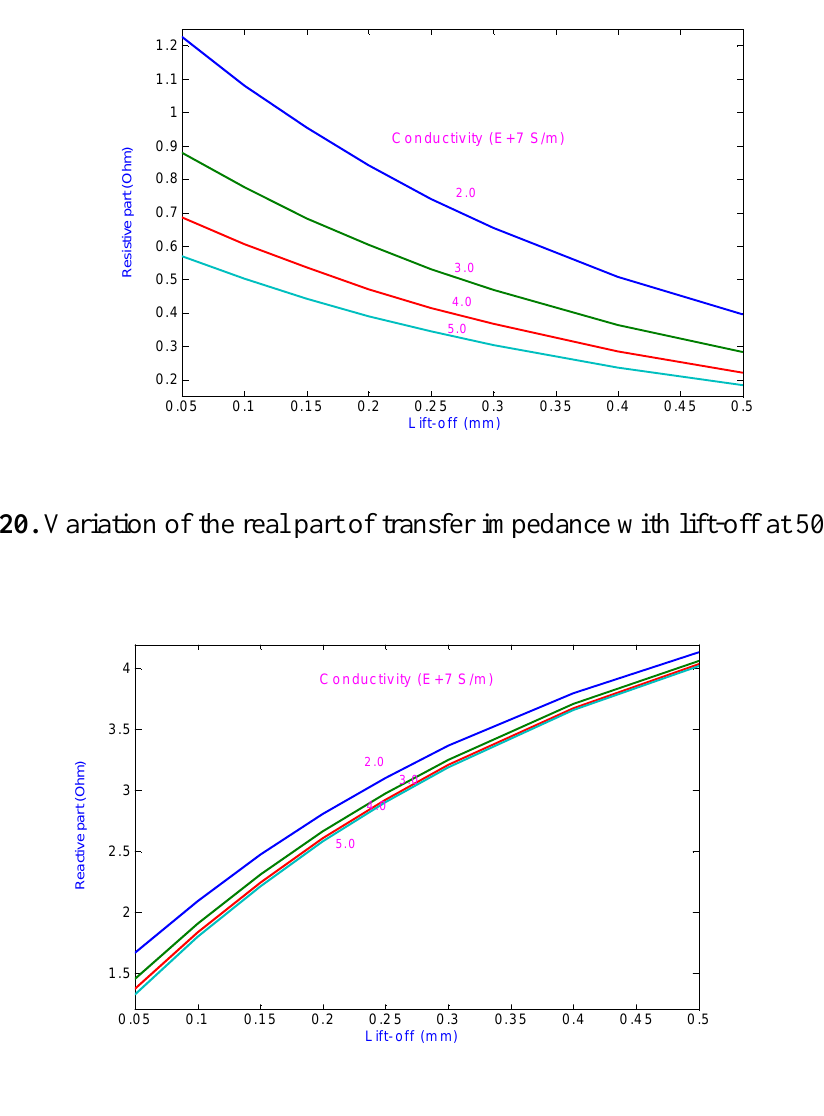
Figure 21. Variation of the imaginary part of transfer impedance with lift-off at 500